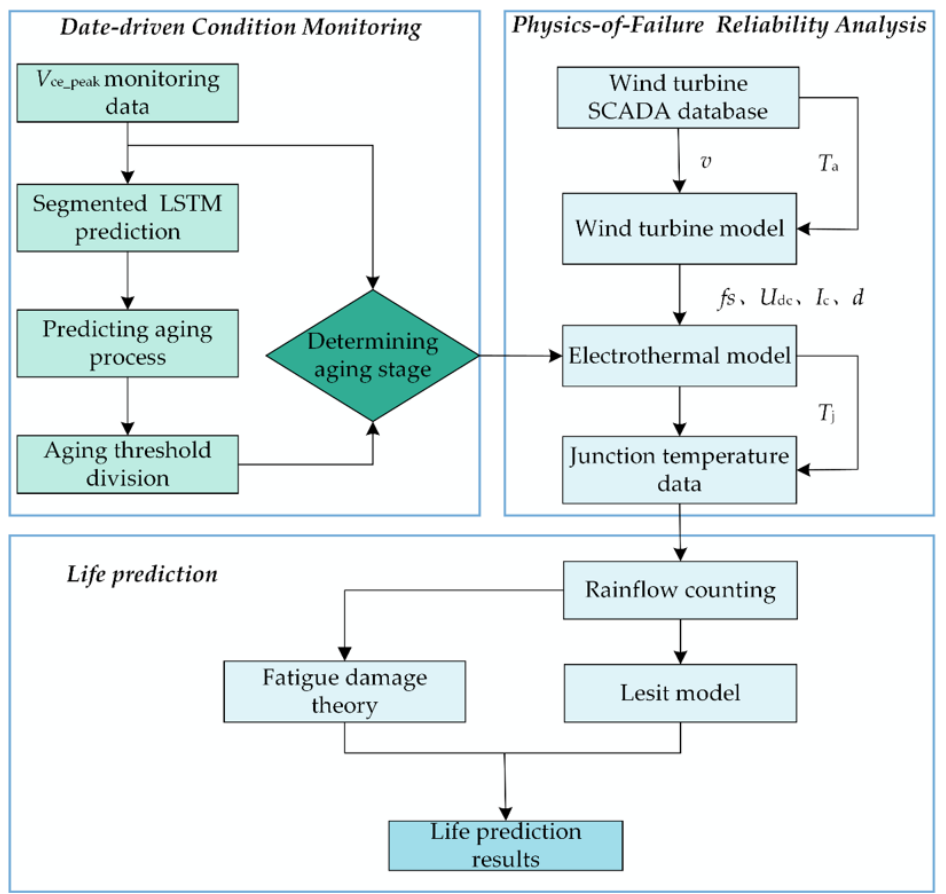
Figure 9. Flowchart of the reliability evolution fusion algorithm.